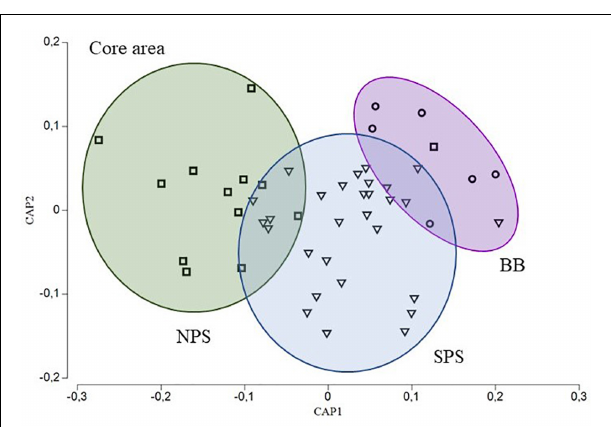
FIGURE 4 | CAP ordination diagram for C. trigloides based on the otolith chemical composition (Ba:Ca, Mg:Ca, Mn:Ca, and Sr:Ca) for the otolith core area. Geographical areas: northern Patagonia shelf (NPS, squares), southern Patagonia shelf (SPS, triangles), and Burdwood Bank (BB,